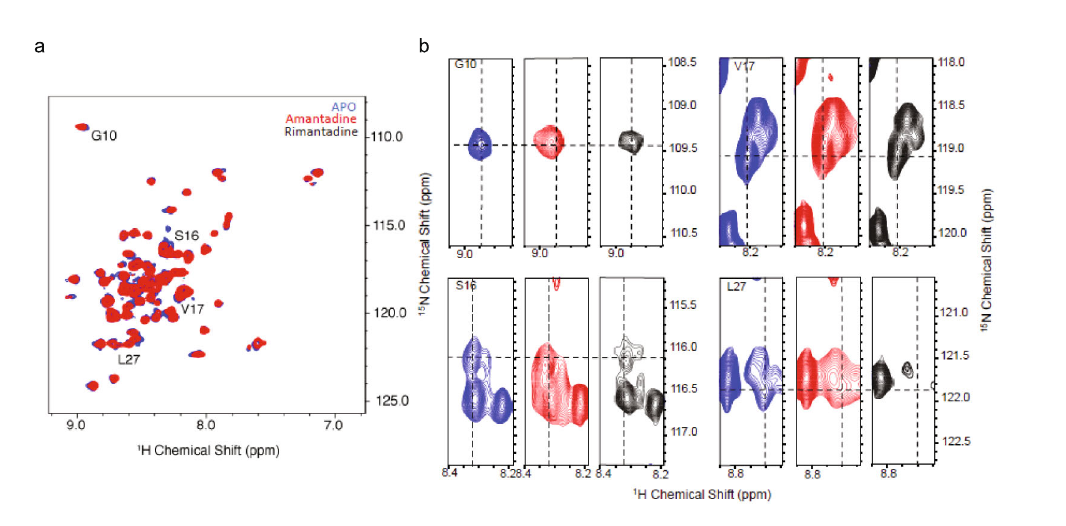
Fig. 2 CSPs from 1 H- 15 N HSQC spectra of full-length Protein E from SARS-CoV-2 in the apo form and after adding amantadine (red) or rimantadine (black). a The backbone amide region of the spectrum, with notable sequence-speci fi c resonance assignments indicated. b Expansion of the spectrum showing shift perturbations for the residues G10, S16, V17, and L27. Measurements were recorded at 50 °C using a Bruker Prodigy probe on a 600MHz